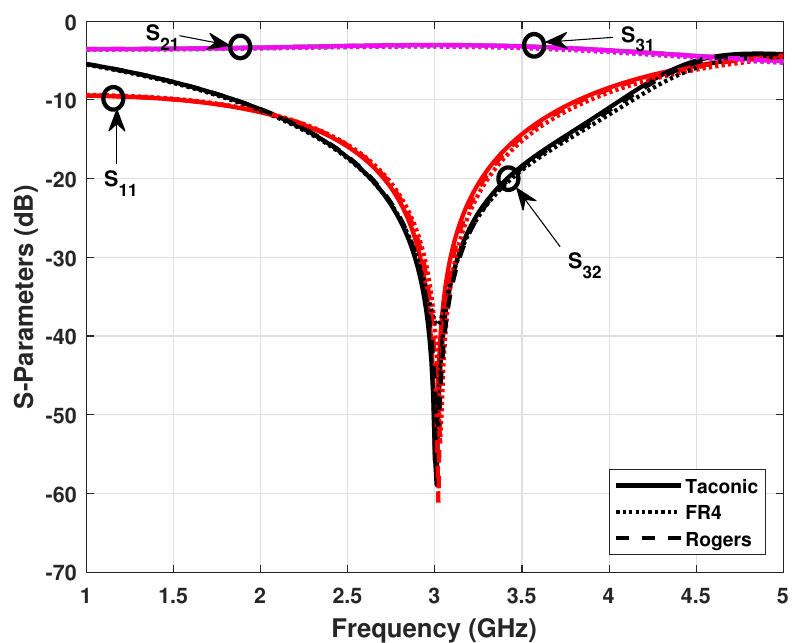
Figure 7. Simulated S–parameters results of the proposed circuit with different